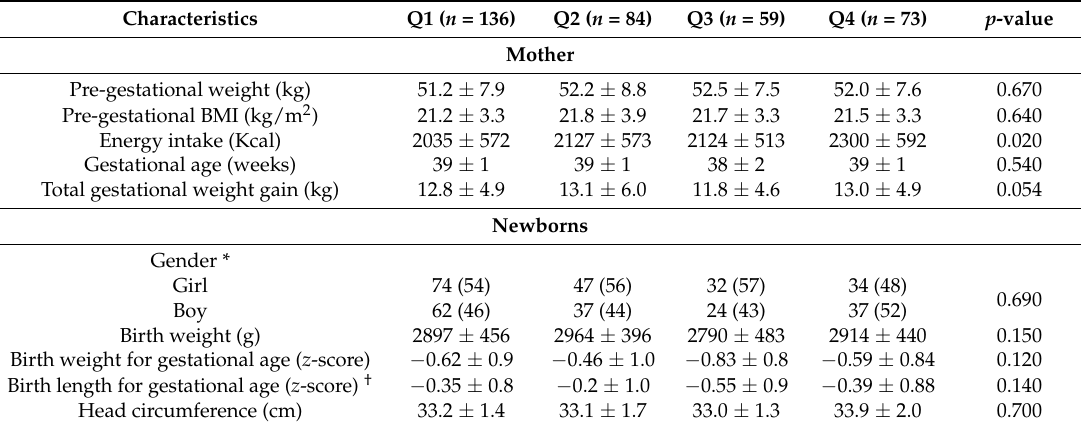
Table 2. Maternal and neonatal characteristics by quartiles of the family support network.